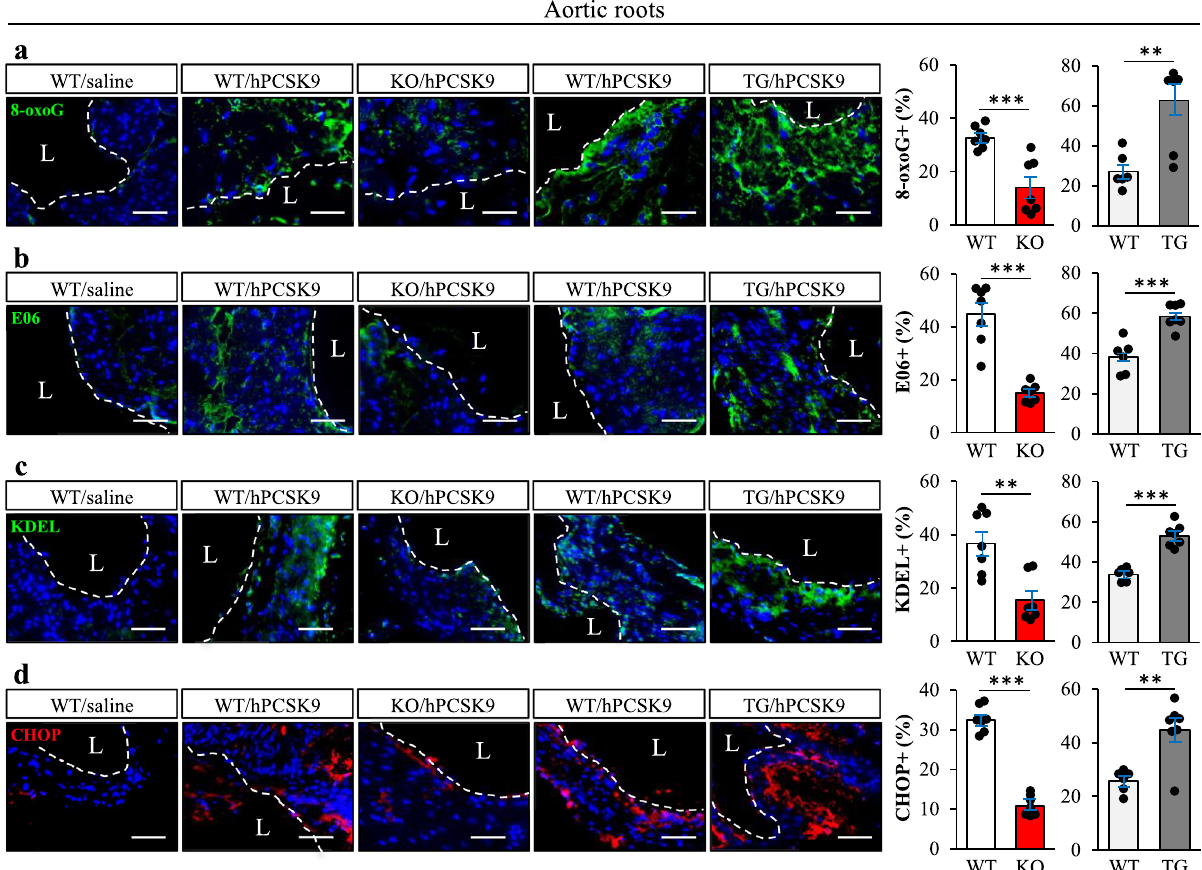
Fig. 5 STK25 modulates aortic oxidative and ER stress in vivo. Atherosclerotic Stk25 knockout and transgenic mice, as well as wild-type littermates, were generated by gene transfer of gain-of-function mutant of PCSK9 combined with an atherogenic western-type diet. Saline-injected wild-type mice fed the western-type diet were included as controls. a – d Representative images of aortic sinus sections processed for immuno fl uorescence with anti-8-oxoG (green), anti-E06 (green), anti-KDEL (green), or anti-CHOP (red) antibodies; nuclei stained with DAPI (blue). Dashed line and L indicate lumen. The scale bars represent 50 µ m. Negative controls by excluding primary antibody or by substituting a primary antibody by an equivalent concentration of the corresponding Ig isotype (Supplementary Fig. 11a, b) did not detect any positive signal, con fi rming the speci fi city of the immunostaining. Quanti fi cation of the staining. Data are mean ± SEM from 6-7 mice per group. L, lumen. ** P < 0.01, *** P < 0.001 for knockout vs . wild-type mice and transgenic vs . wild- type